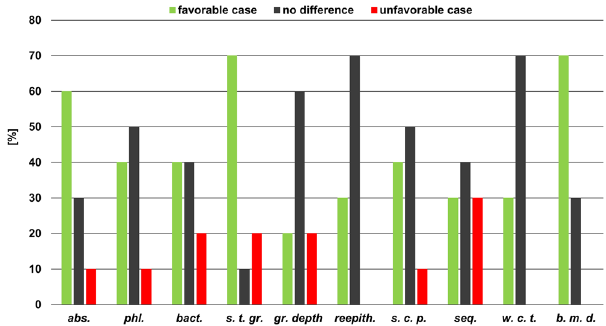
Figure 4. Results of the descriptive statistic performed to discover favourable (green), no difference (grey) and unfavourable (red) cases of wound healing in each analysed histological